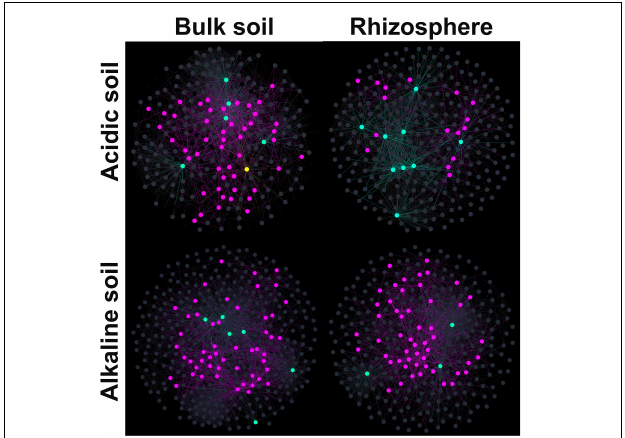
FIGURE 5 | Co-existence networks for microeukaryotic communities in acidic bulk, acidic rhizosphere, alkaline bulk, and alkaline rhizosphere soil. The co-existence networks were constructed using the SparCC method to correlate amplified sequence variants (ASVs). For the node colors, yellow represents network hubs, light blue represents module hubs, purple represents connectors and dark gray represents peripherals.